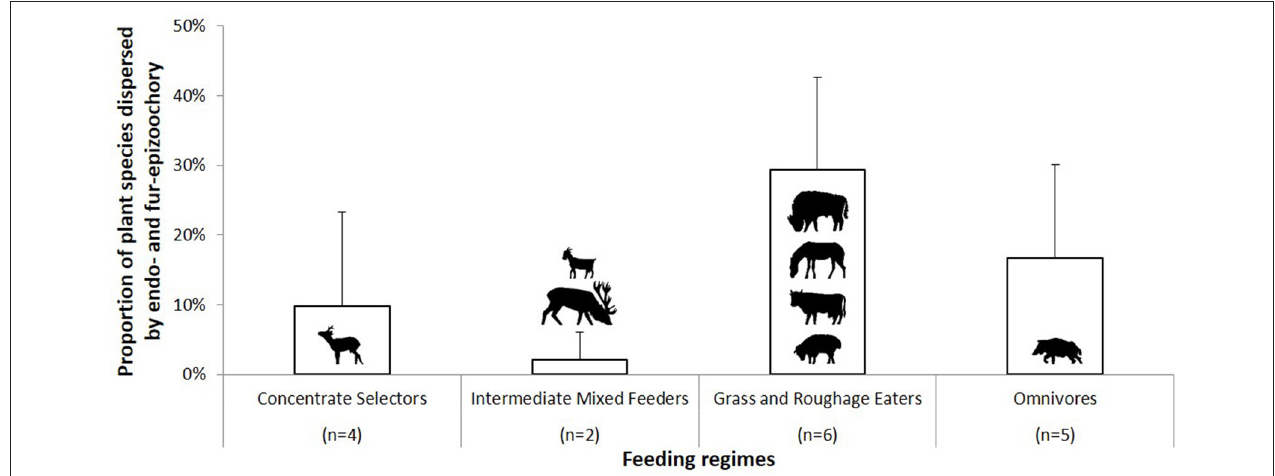
FIGURE 3 | Proportion of plant species dispersed through endozoochory and fur-epizoochory by ungulates according to their feeding regime ( Table 5 ). Concentrate Selectors are represented by roe deer ( Capreolus capreolus ); Intermediate Mixed Feeders by goat ( Capra aegagrus hircus ) and red deer ( Cervus elaphus ); Grass and Roughage Eaters by American bison ( Bison bison ), donkey ( Equus asinus ), cattle ( Bos taurus ), and sheep ( Ovis aries ) and Omnivores by wild pig ( Sus scrofa